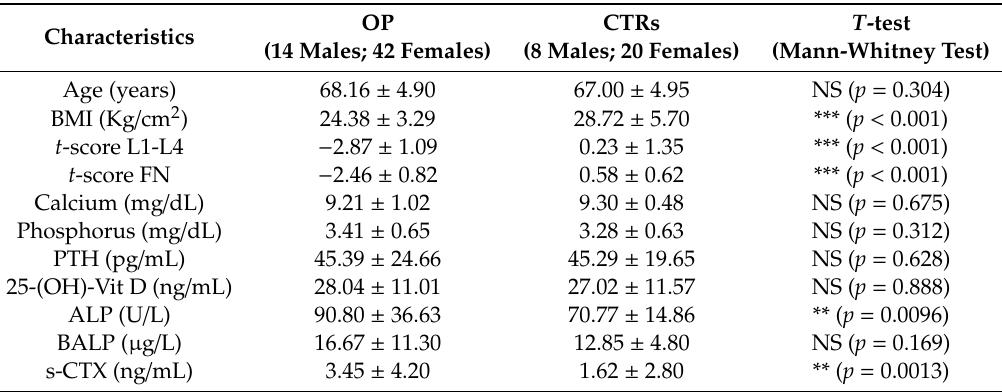
Table 1. Characteristics of Osteoporosis (OP) patients and healthy controls (CTRs).